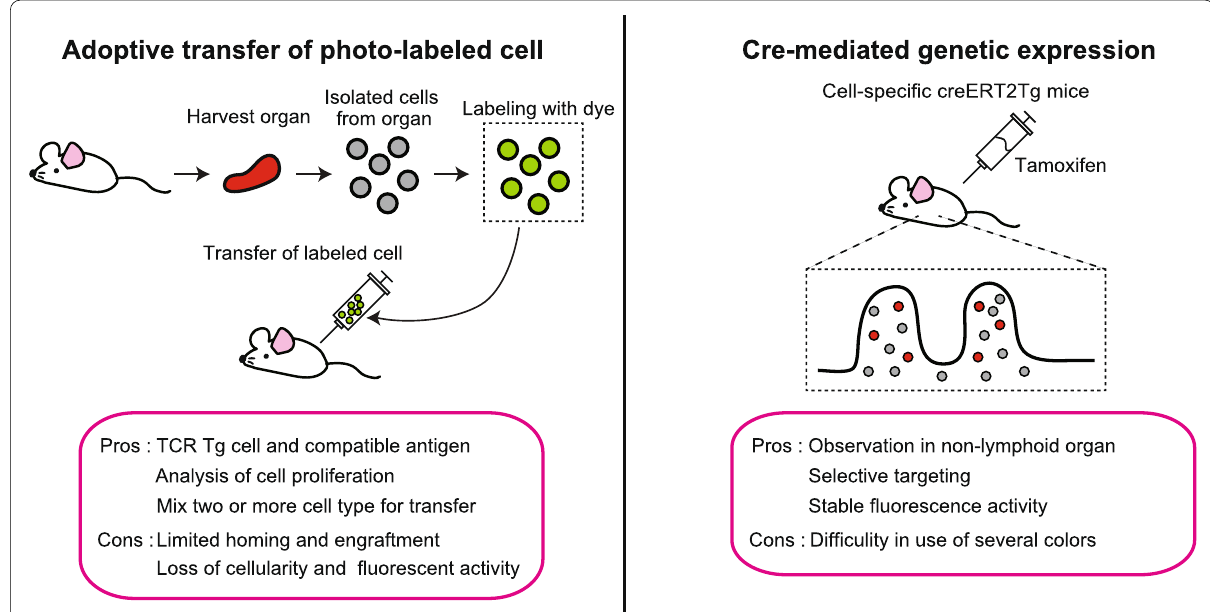
Fig. 2 Two different techniques for in vivo imaging. In the procedure shown to the left, cells are isolated from organs harvested from mice, labeled with a specific dye, and transferred into mice. On the other hand, the procedure shown on the right establishes mice transgenic with the creERT2 gene and fluorescent protein targeting specific cells. The mice are then injected with the hormonal substance tamoxifen, which induces the activity-dependent expression of the fluorescent protein by Cre recombinase, allowing in vivo observation. Pros and cons for each method are listed at the lower part of the